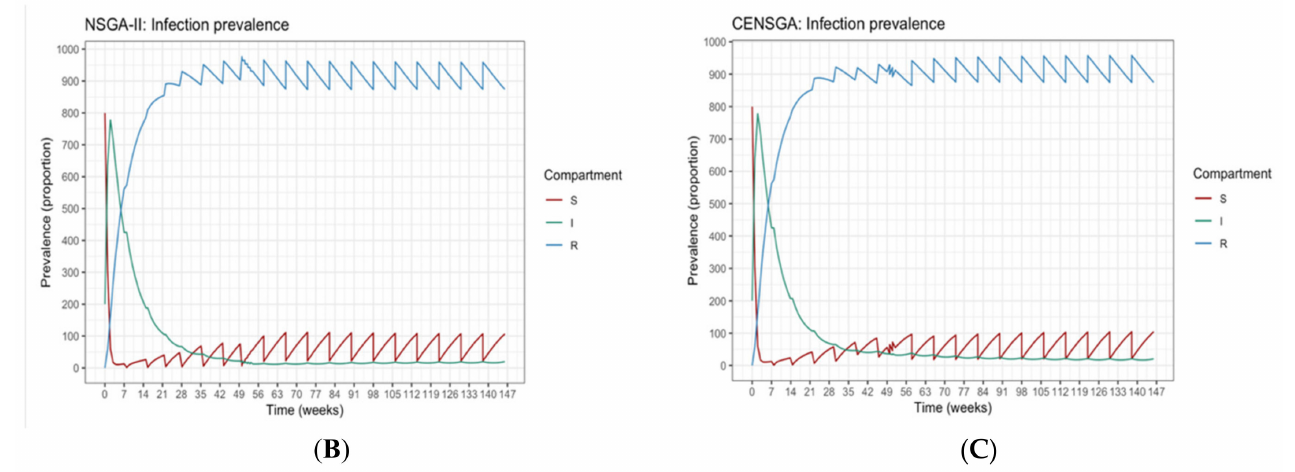
Figure 11. SIR behavior under different situation. ( A ) SIR general behavior. ( B ) Behavior of the selected solution from NSGA-II. ( C ) Behavior of the selected solution from CENSGA.